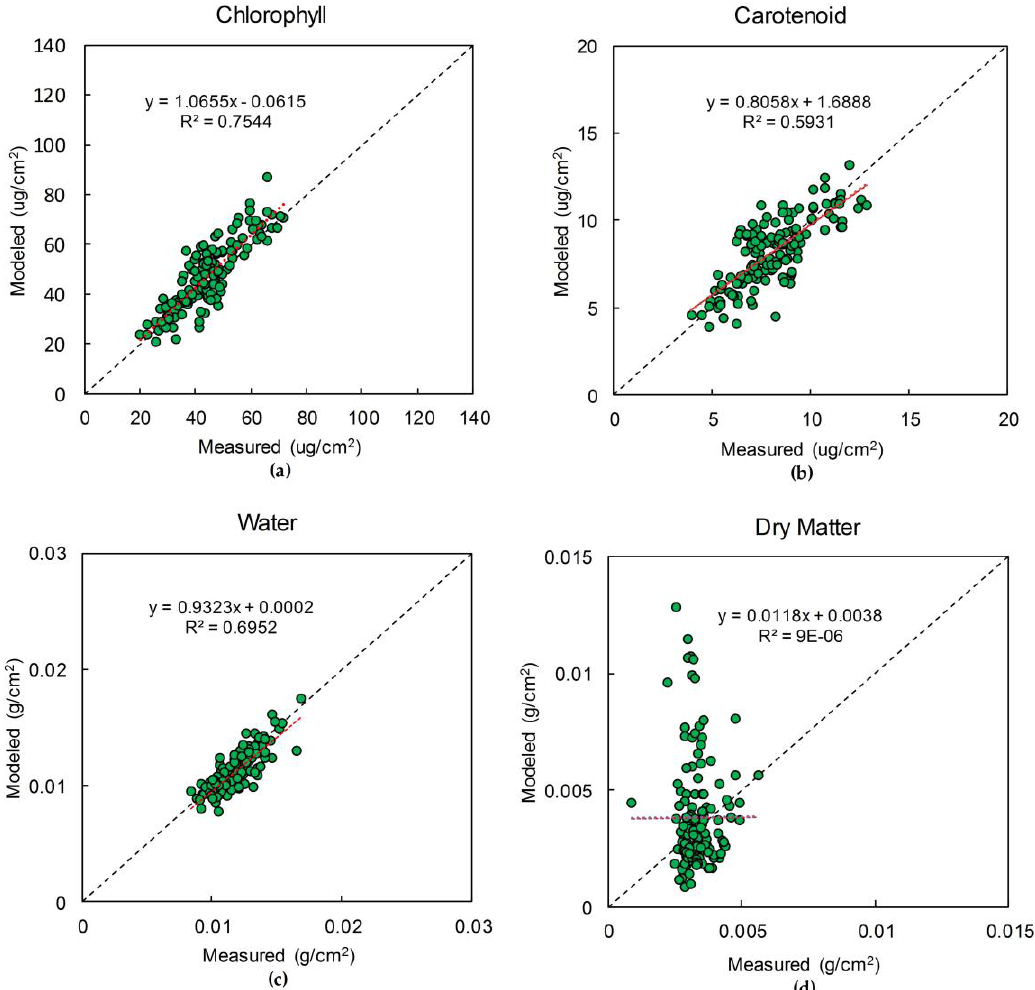
Figure 3. Measured versus modeled biochemical constituents for Maize ( Zea mays L.) using PROSPECT5 inversion. ( a ) chlorophyll; ( b ) carotenoid; ( c ) water and ( d ) dry matter.